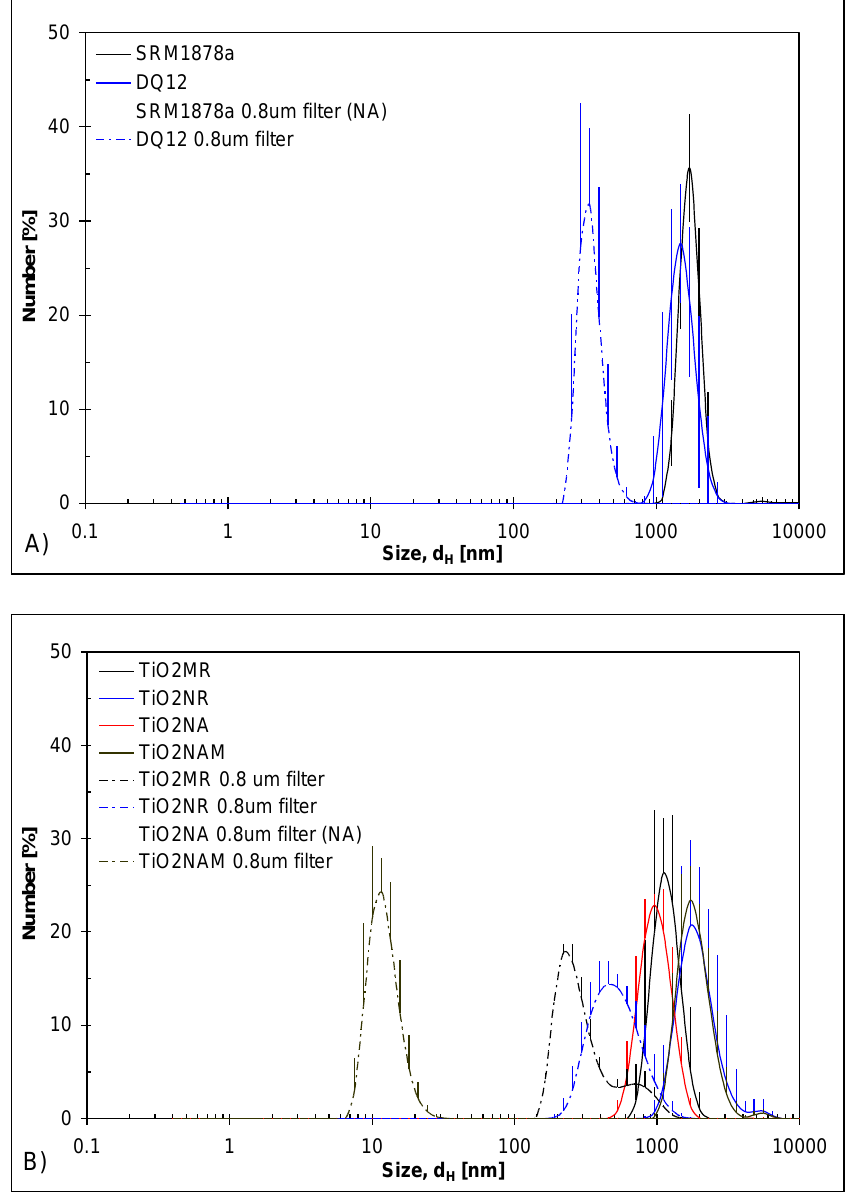
FIGURE 1. DLS spectra of the particles in saline. DLS spectra showing the hydrodynamic particle number size distributions (d ) of the saline suspensions H used for i.t. instillation. (A) DLS spectra are shown for the stock SRM1878a and DQ12, as well as the 0.8-  m-filtered DQ12 suspensions; it was not possible to obtain a suitable spectrum from the 0.8-  m-filtered SRM1878a suspensions due to a low number of particles. (B) DLS spectra are shown for the stock TiO 2 suspensions and 0.8-  m-filtered samples. In (A) and (B), the presence of coarse particles outside the upper detection limit is indicated by an arbitrary x-axis error bar at the coarsest valid size data for SRM1878a and TiO 2